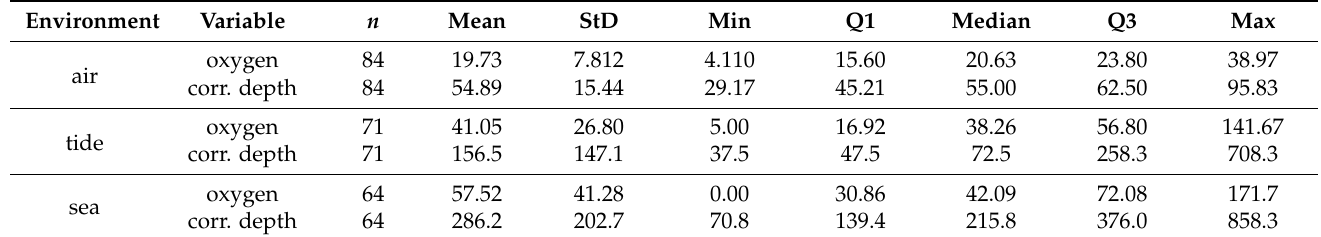
Table 3. The descriptive statistics of input data related to the NiTi2